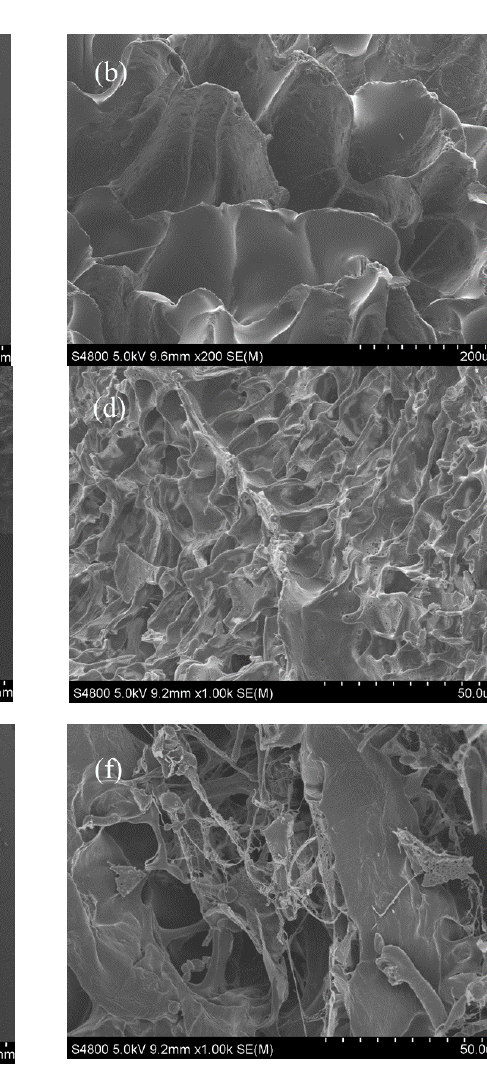
Figure 3. Thermogram of pure components and hydrogel beads: ( a ) alginate, ( b ) starch ( c ), kaolin, ( d ) PNIPAAm, ( e ) SA, ( f ) SAP13, and ( g ) SAPK2.